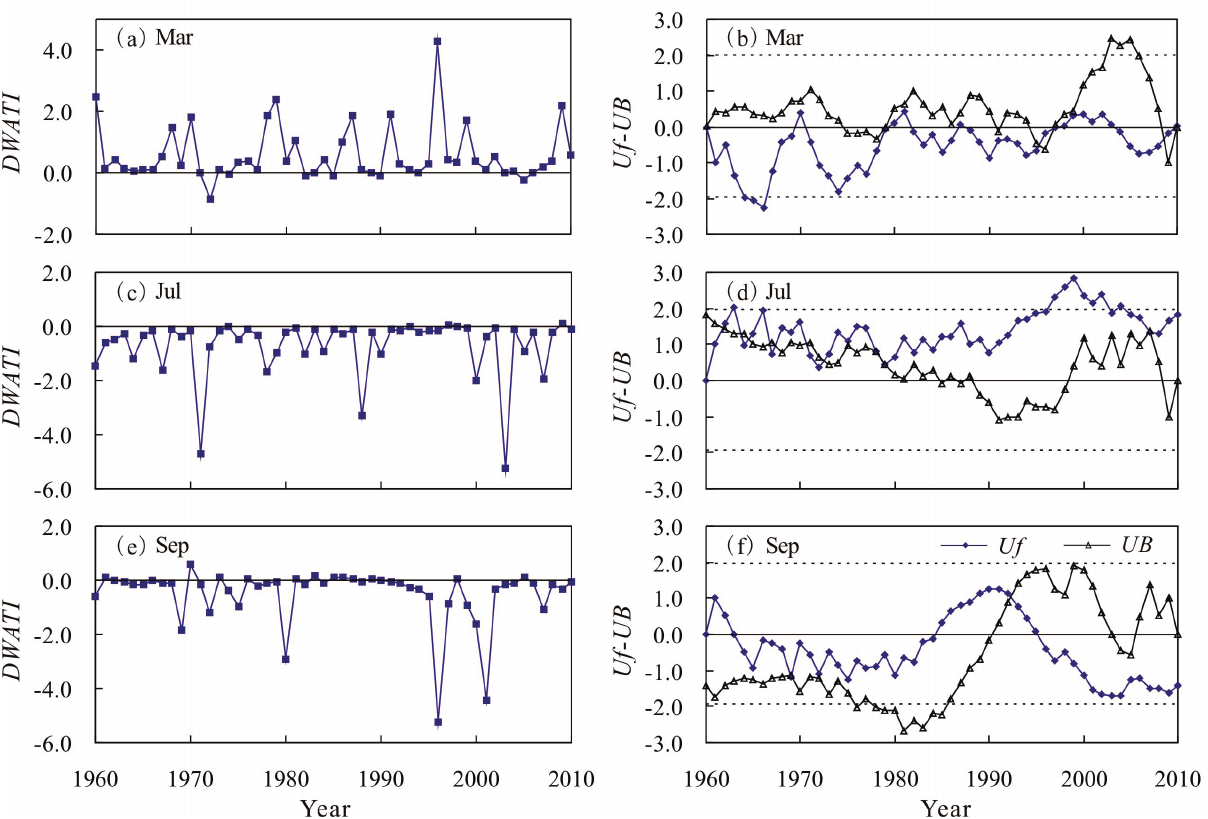
Figure 6. Inter-annual variation of DWATI in March ( a ), July ( c ) and September ( e ) and their corresponding M–K trend tests ( b , d , f ,) (the horizontal dashed lines in ( b , d , f ,) represent the critical value of the 0.05 significance